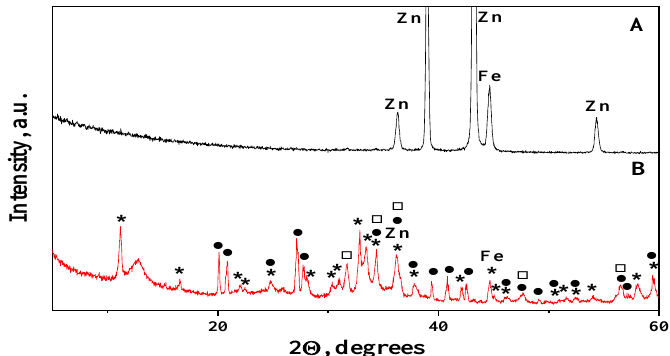
Figure 6. XRD patterns of non-treated ( A ) and treated Zn-PANI/SiO 2 ( B ) coating: * — Zn 5 (OH) 8 Cl 2 ·H 2 O; — Zn(OH) 2 ; — ZnO.